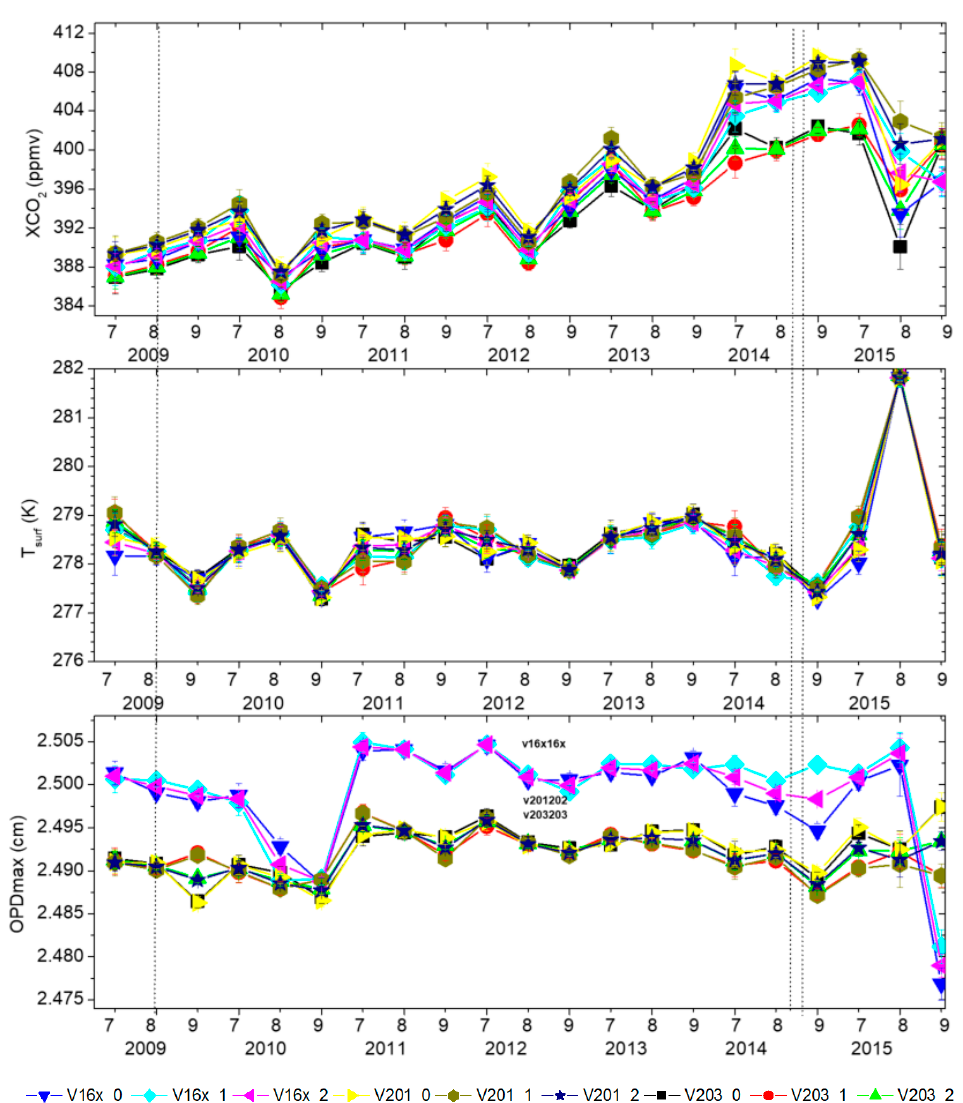
Figure 6. Time series for XCO 2 (upper panel), surface temperature T surf (middle panel), and OPD max (bottom panel) including August 2015, for each version (V16x, V201, V203) as a function of year/month and OPD direction (0 = forward, 1 = backward, 2 = both). Vertical dashed lines correspond to the platform or instrument events introduced in Table 1.